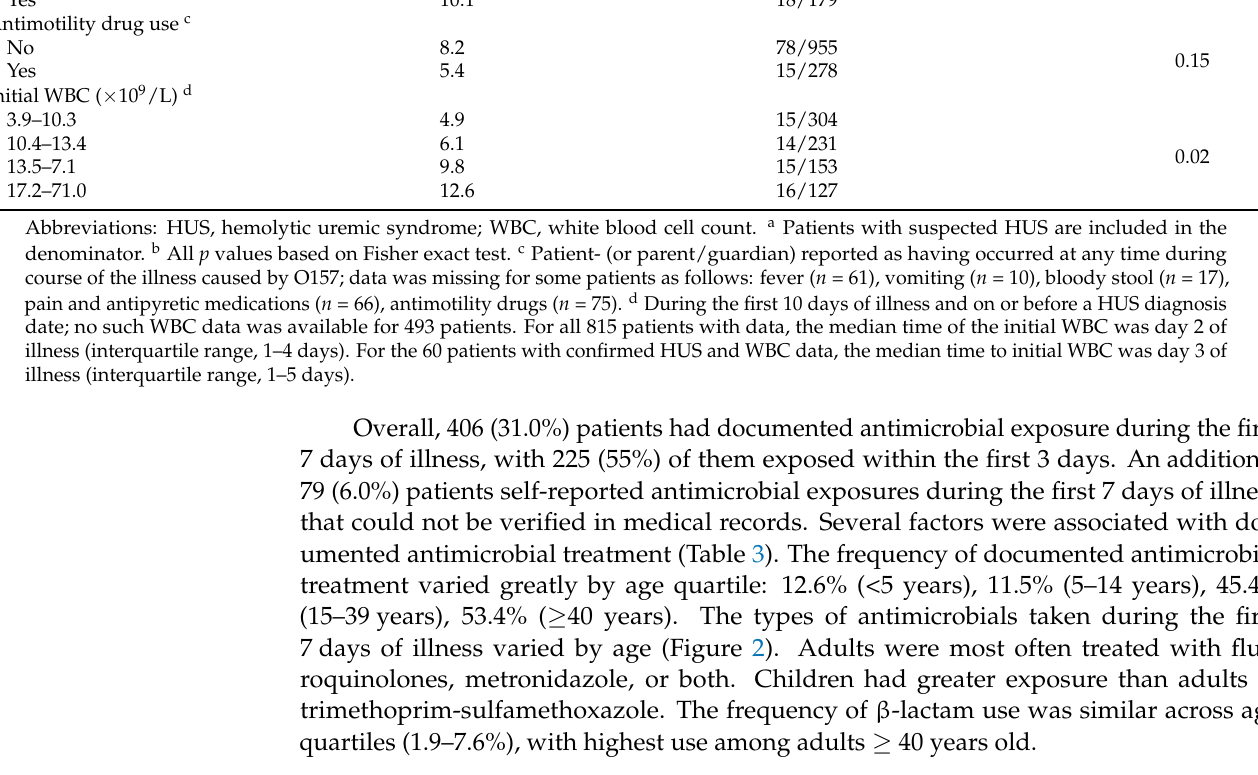
Table 3. Frequency of documented antimicrobial use during the first 7 days of illness (and before HUS diagnosis) by demographic and clinical